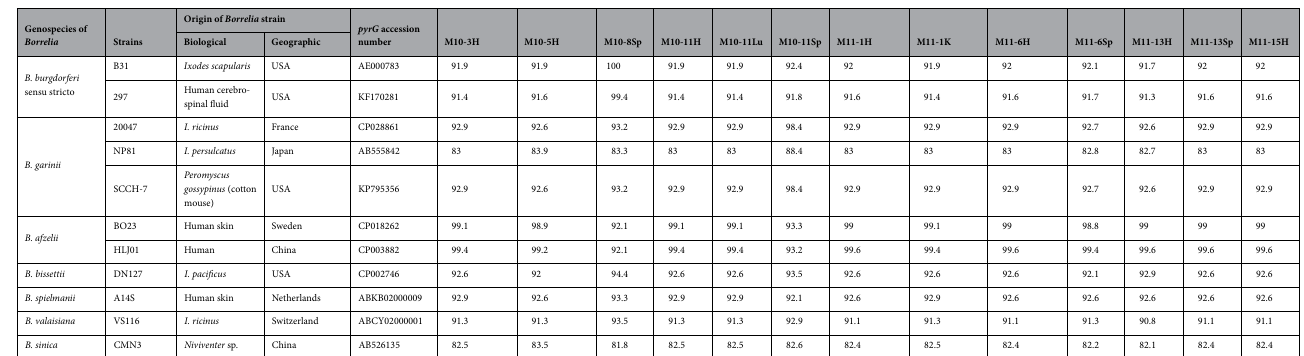
Table 2. Similarity between Borrelia pyrG gene sequences from GenBank and the wild rodents captured in this study † . † pyrG , CTP synthase